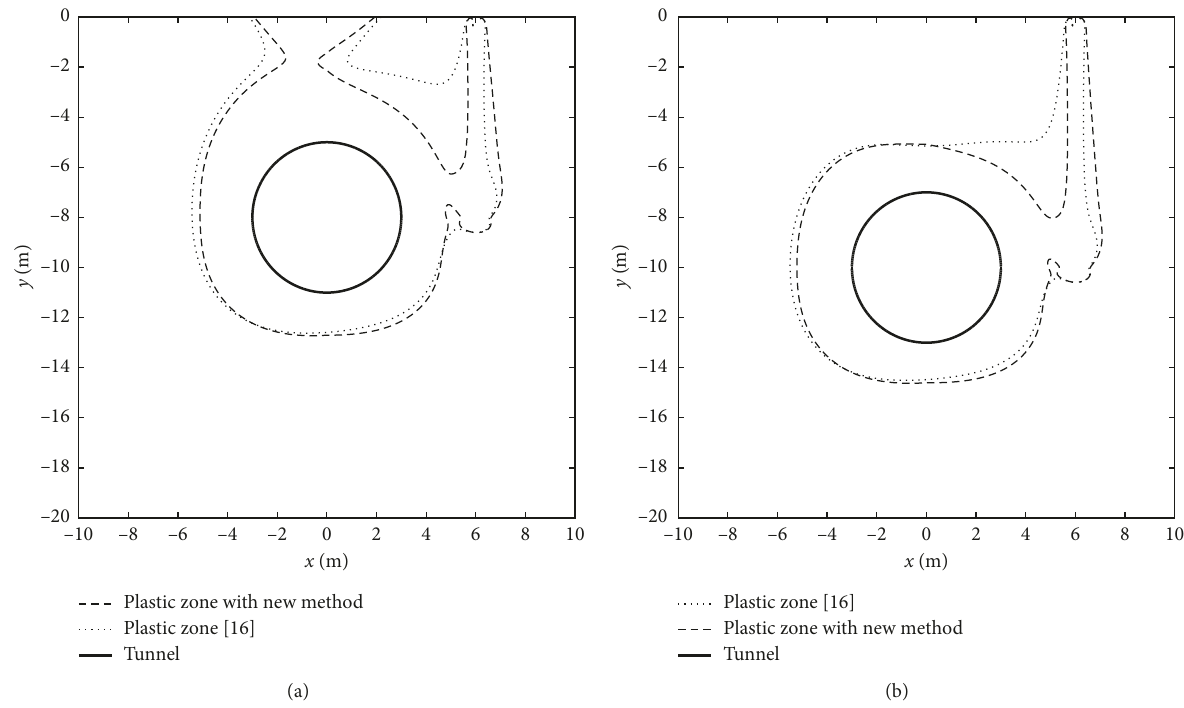
Figure 4: Comparisons of potential plastic zones with pile load. (a) Relative depth � 0.83. (b) Relative depth �